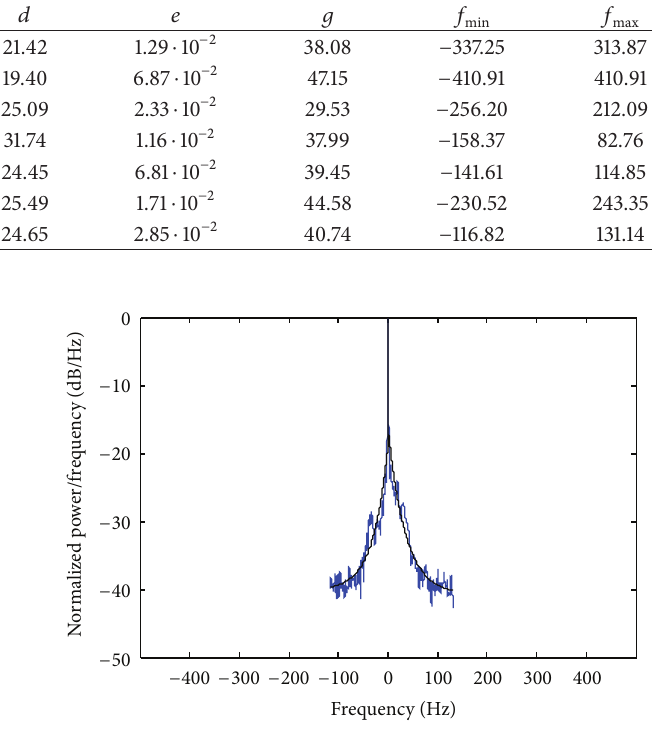
Figure 15: Example G: estimated PSD and corresponding exponen- tial fitting ( 𝑎 = 21.21 , 𝑏 = 3.30 ⋅ 10 −2 , 𝑐 = 40.20 , 𝑑 = 24.65 , 𝑒 = 2.85 ⋅ 10 −2 , 𝑔 = 40.74 , 󳵻𝑓 = 247.96 , and 𝛾 = 0.06